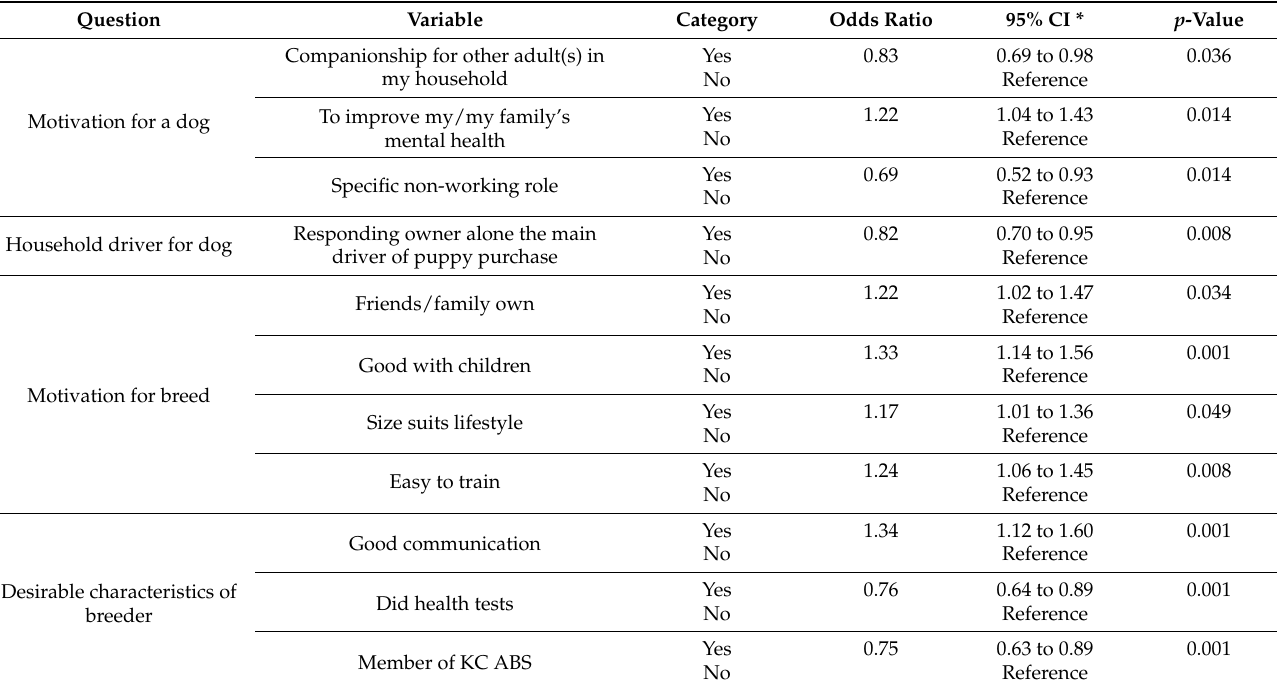
Table 5. Final multivariable model for pre-purchase motivations associated with purchasing a ‘Pandemic Puppy’ during 2020 compared with a 2019 puppy in the UK. * Confidence